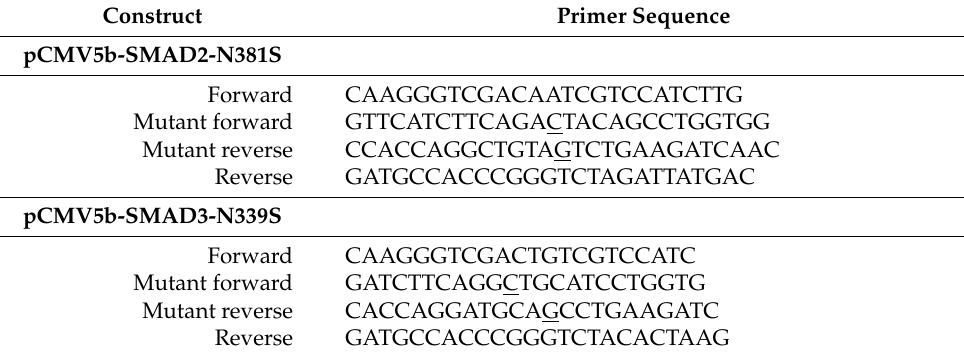
Table 1. Primer sequences used for the generation of SMAD-NS mutants.